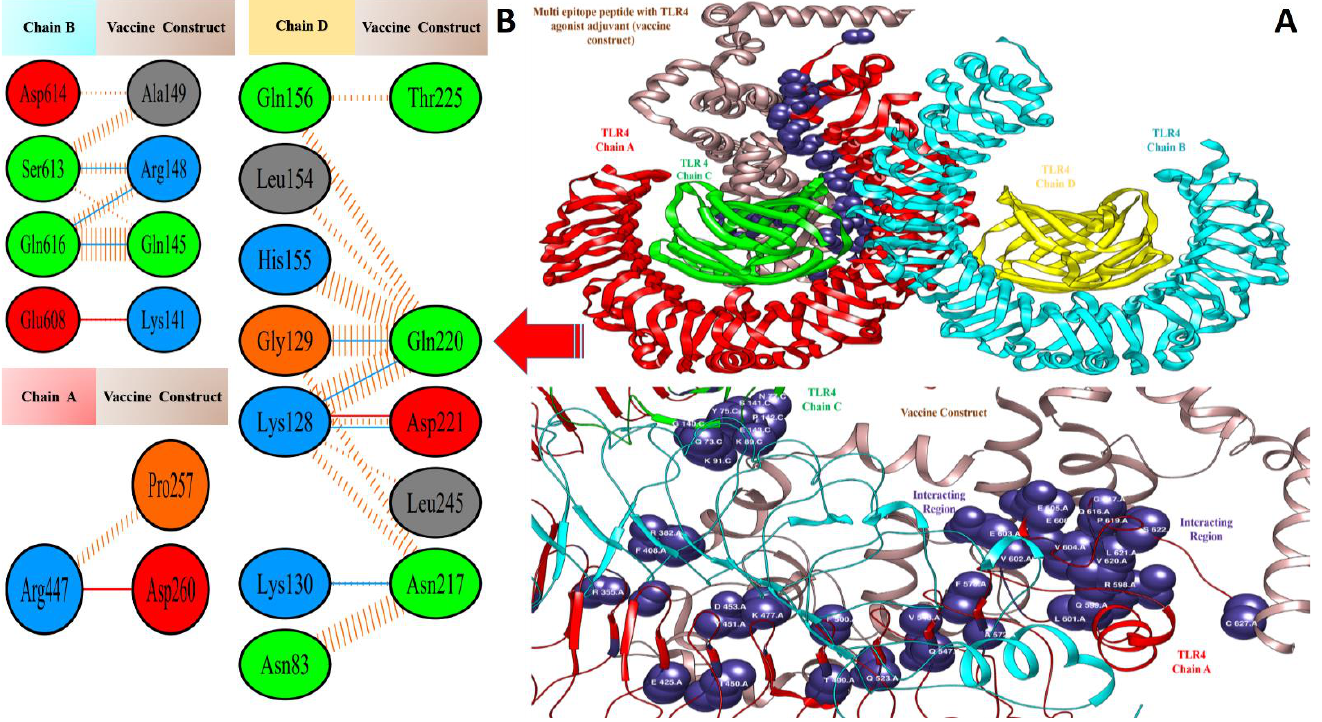
Figure 7. Docked pose of TLR4-agonist vaccine with TLR4: ( A ) every single entity of the complex is self-explanatory. Each chain of the receptor TLR4 is represented in a different colour, i.e., chain A: dark red, chain B: deep sky blue, chain C: green, and chain D: yellow, and the designed vaccine construct TLR4-agonist is represented in dim grey; interacting residues between receptor and vac- cine are shown in dark slate blue. ( B ) Residue-residue interaction between vaccine construct and TLR4 chains